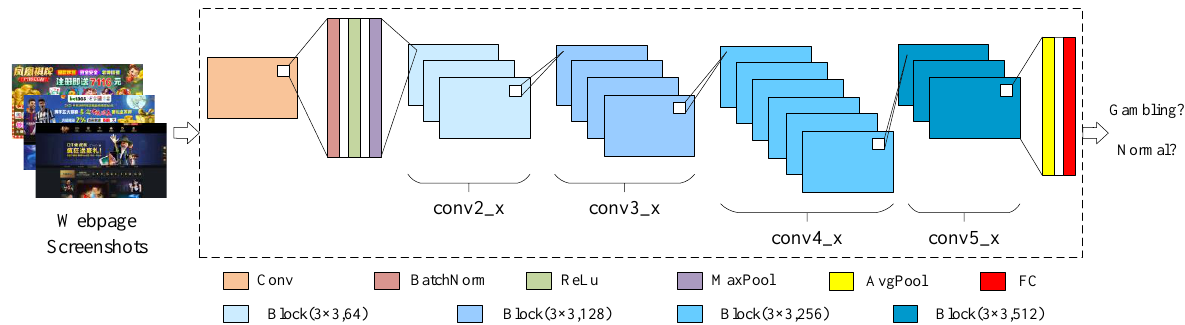
Figure 4. The structure of the image